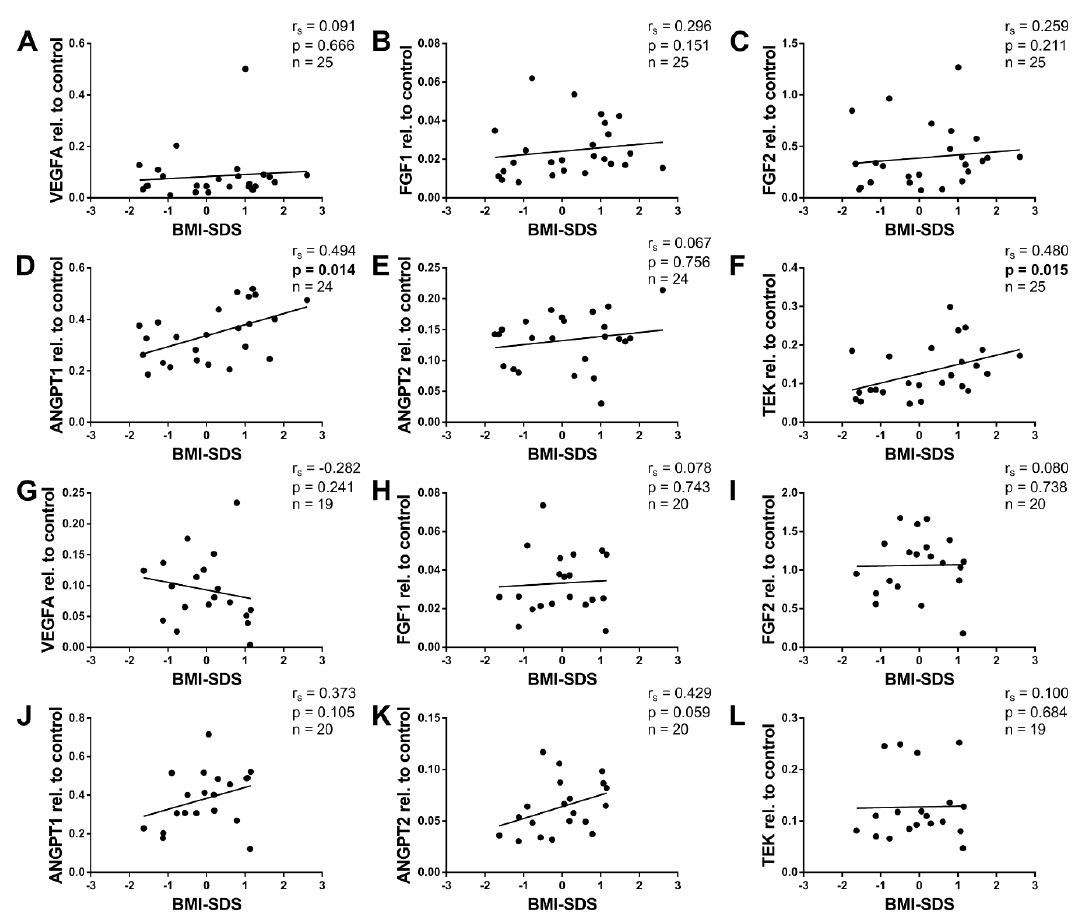
Figure A3. Association of angiogenic gene expression with BMI-SDS in the WAT of infants < 6 and children ≥ 6 months. Total RNA was isolated, reverse transcribed, and subjected to qPCR analysis using specific primer pairs as indicated. Respective gene expression was calculated as described in Methods and plotted against BMI-SDS. ( A – F ) Like in the analysis with all children, ANGPT1 and the receptor TEK correlated positively with BMI-SDS in the infants < 6 months ( D , F ), while VEGFA, FGF1, FGF2, and ANGPT2 showed no significant correlation ( A – C , E ). ( G – L ) We found no significant correlation of angiogenic factors with BMI-SDS in the children ≥ 6 months. Spearman correlation coe ffi cient r s and p value, as well as number of subjects, are given in each scatter plot. Significant p values ( p < 0.05) are indicated in bold. Trend lines were calculated as linear regressions.